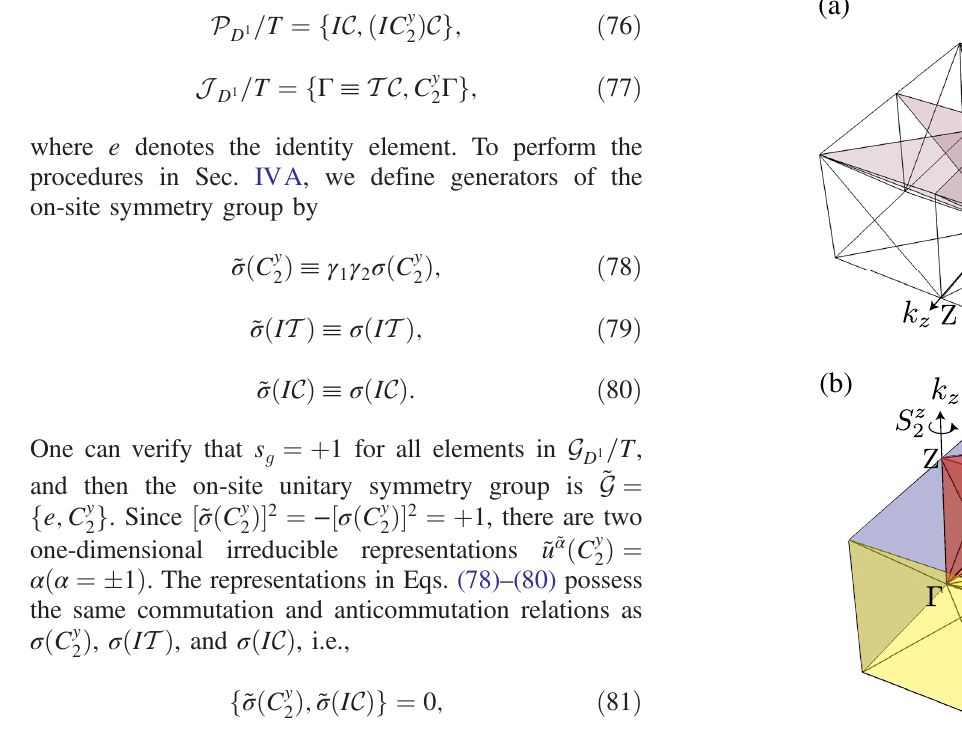
FIG. 9. Illustrations of cell decomposition for the half BZ in P 2 =m 1 0 (a) and the quarter BZ in Pmc 2 1 1 0 (b). Here, we omit orientations except for the 1-cells denoted by D 1 . In both (a) and (b), adjacent 2-cells to the 1-cell D 1 are colored by red. In (b), blue and yellow planes represent the mirror and glide planes of MSG Pmc 2 1 1 0 ,